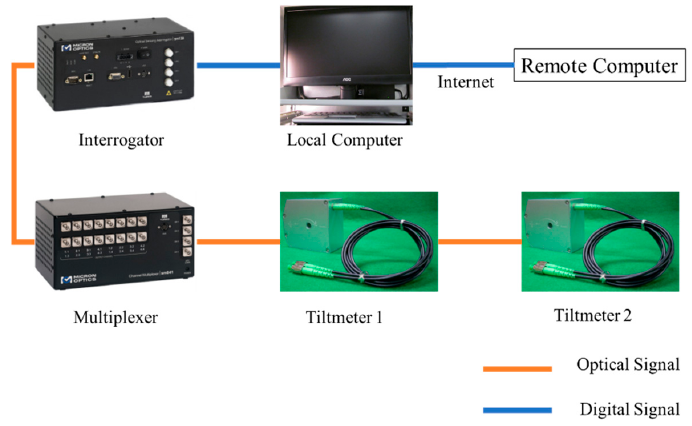
Figure 2. System configuration.